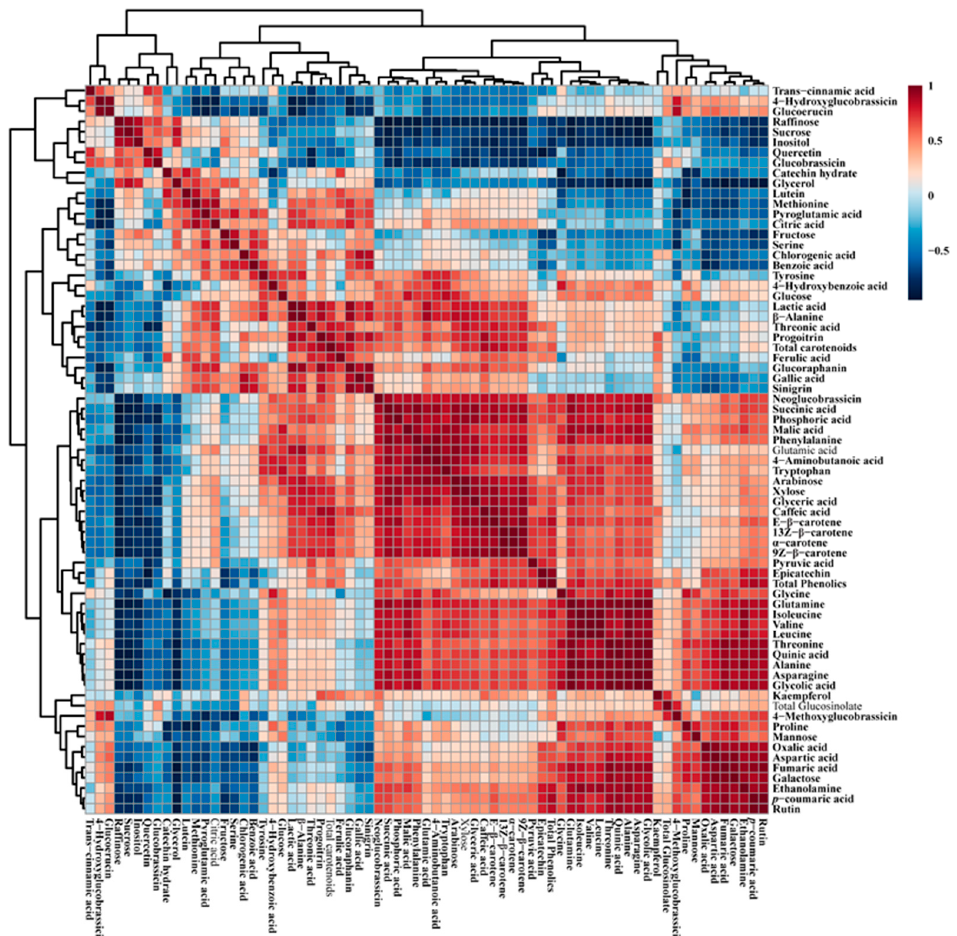
Figure 8. Correlation matrix of metabolites identified in kohlrabi sprouts after exposure to different LED light conditions. Each colored box represents a Pearson’s correlation coefficient for a pair of compounds, and the value of the correlation coefficient is indicated by the intensity of the blue or red color, as shown on the color scale.